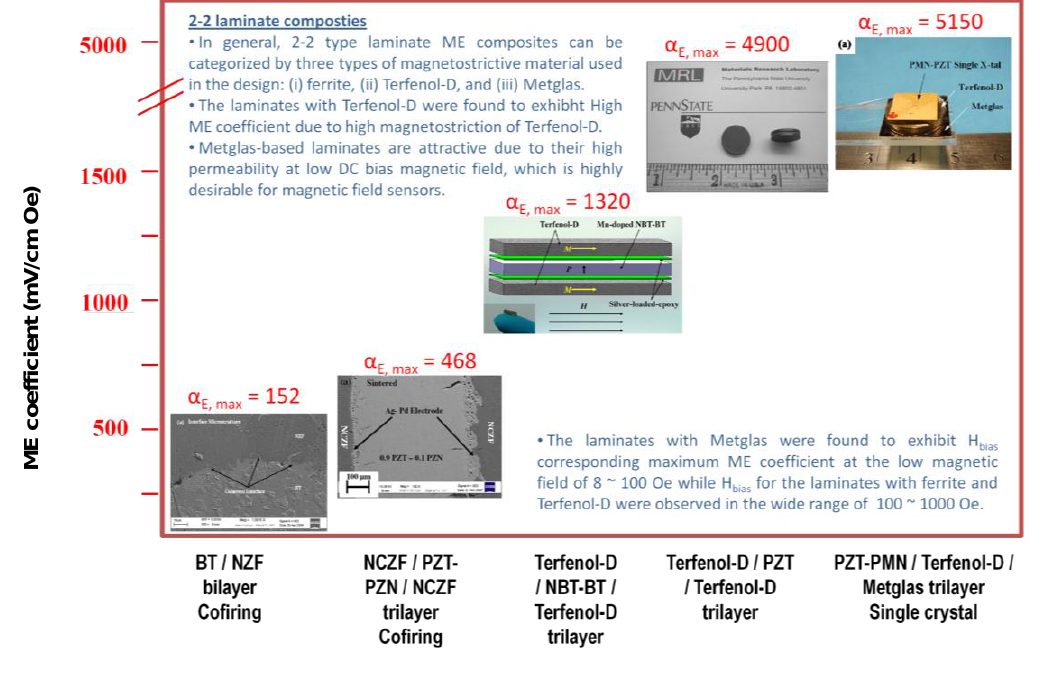
Figure 20. Magnetoelectric coefficient for 2-2 laminate composites in off-resonance conditions.